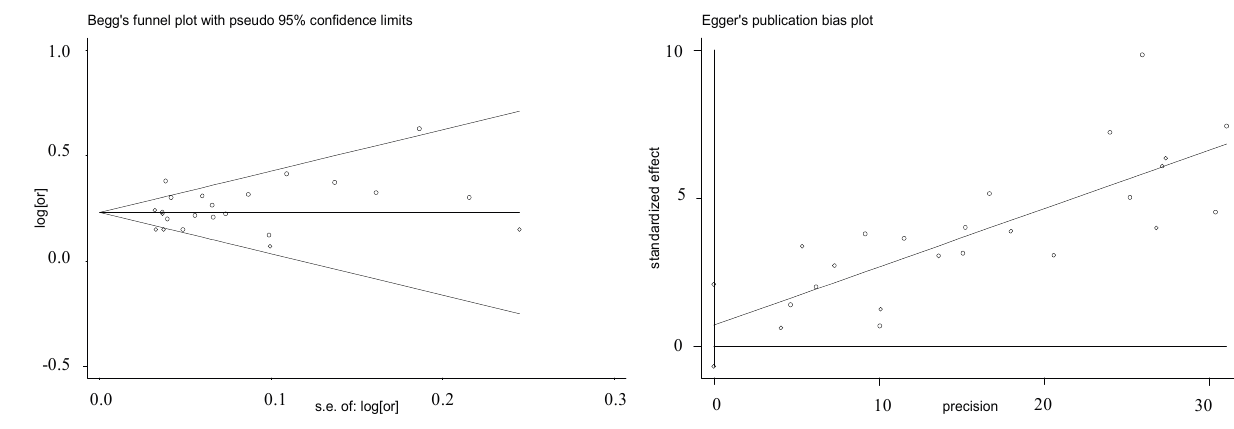
Figure 2. Funnel plot for studies of the association of CHD and rs4977574 a . a: Horizontal axis represents the standard error of log OR; Vertical axis represents the log OR. The “s.e.” denotes standard error.